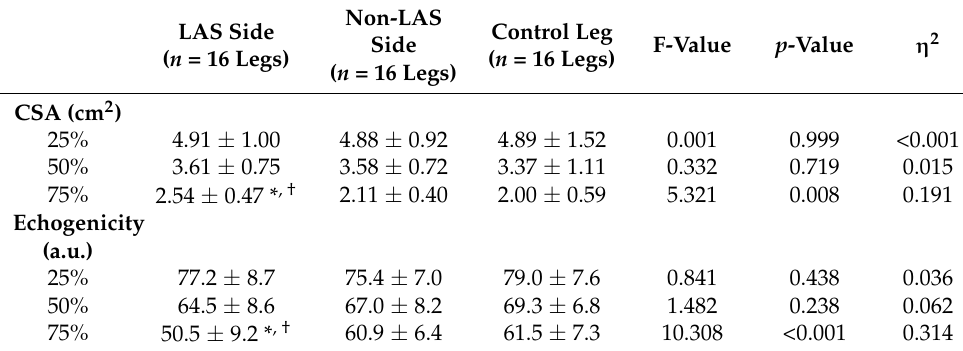
Table 3. The CSA and echogenicity of the peroneus muscles in the LAS and non-LAS sides and in the control leg.